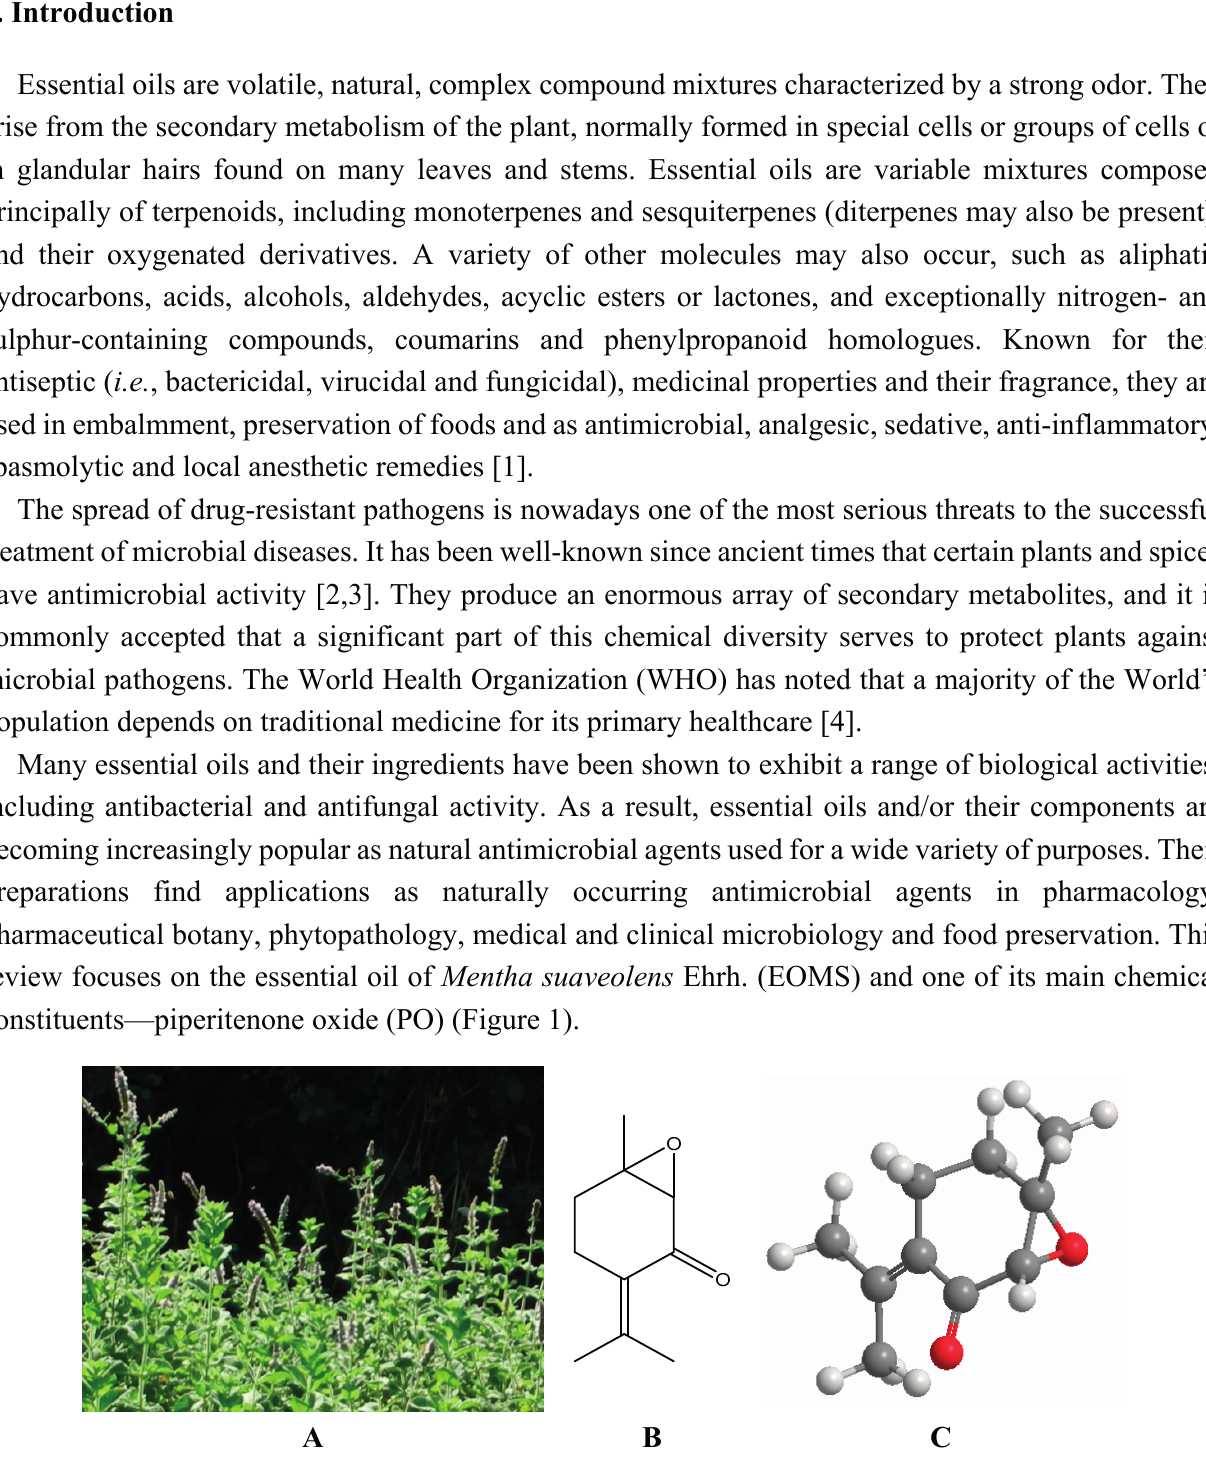
Figure 1. Wild MS ( A ) and PO 2D ( B ) and 3D ( C ) structure